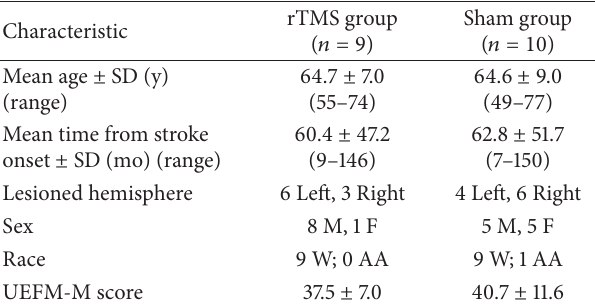
Table 1: Demographics of the study